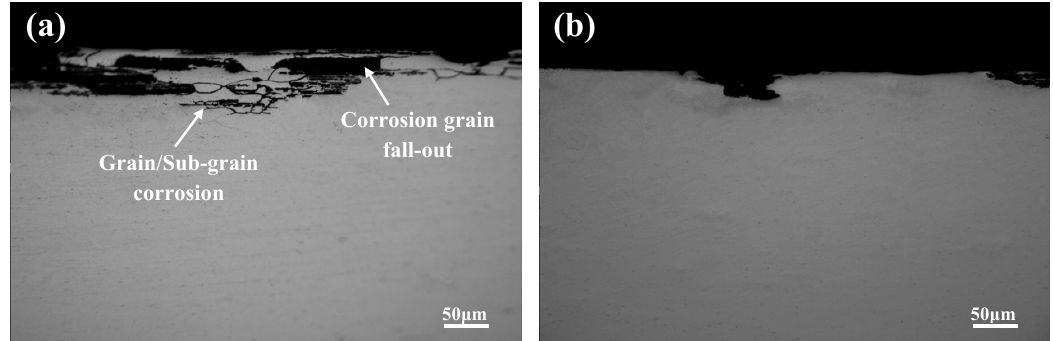
Figure 9. Representative cross-sectional corrosion morphologies of the five aged samples immersed for 1 h in IGC solution representing: ( a ) A1, ( b ) PDA.